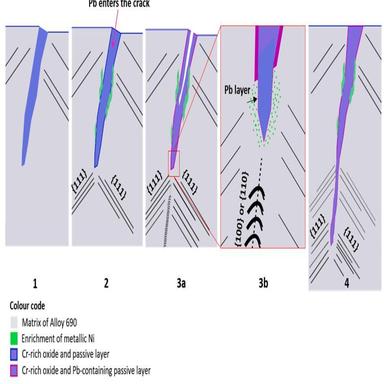
Schematics describing the sequence of events related to the TG PbSCC in Pb + NaOH environment. (1) Proto-crack nucleation; (2) stress localisation at the tip; (3a) degradation of the protective properties of the passive film of Alloy 690 due to the Pb in the environment; (3b) deposition of Pb-containing layer and selective oxidation occurring at the crack tip; (4) cleavage along or planes.